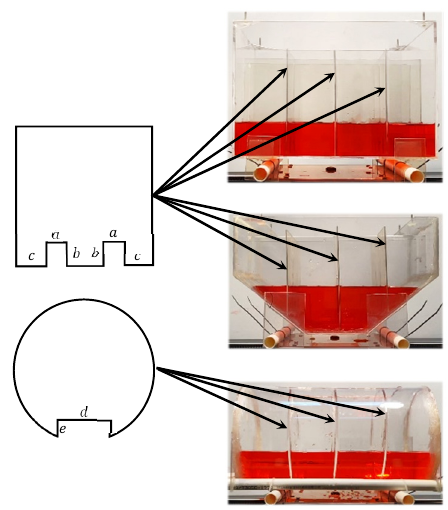
Figure 4. Positions of baffle walls and liquid-traveling cavities.